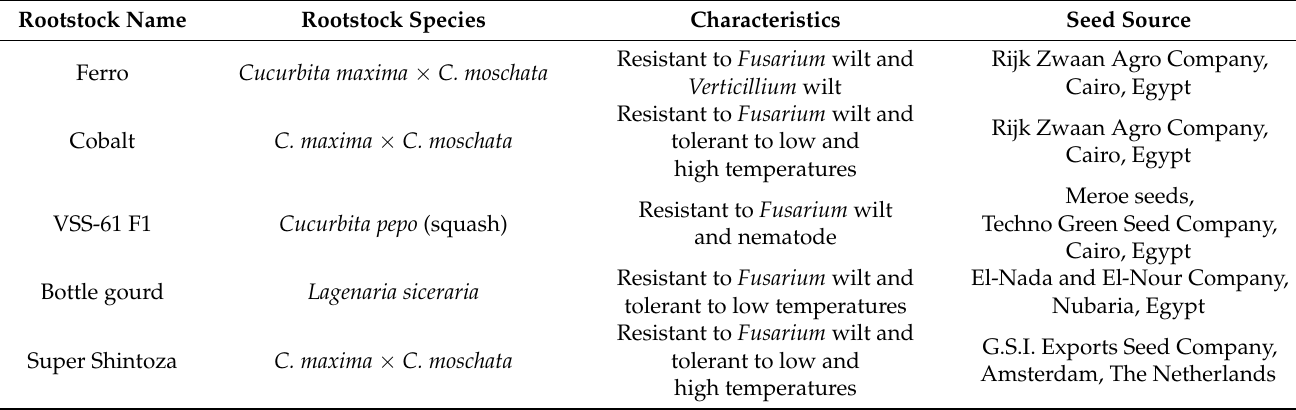
Table 1. Description of the cucurbit rootstocks used for grafting cucumber plants under combined heat and soil salinity